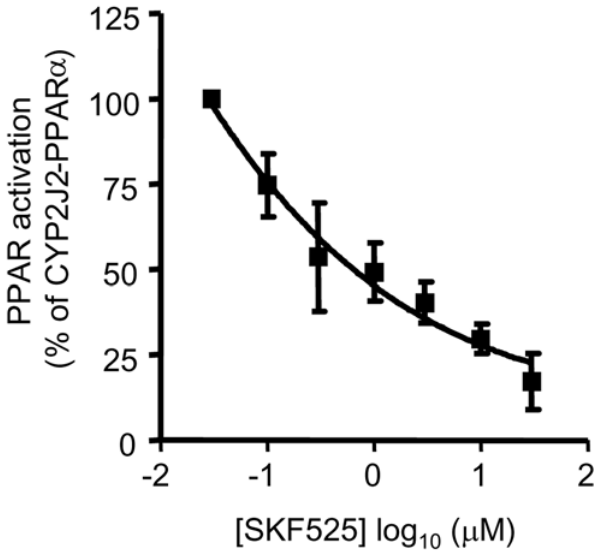
Figure 2. Synergistic activation of PPAR a by CYP2J2 requires an active CYP2J2. Cells were co-transfected with PPAR reporter gene, CYP2J2 and PPAR a , and treated with the epoxygenase inhibitor SKF525A (0–30 m M). SKF525A caused a concentration-dependant inhibition of PPAR reporter gene activation. Data represents n=9 2 12 replications from 4 separate